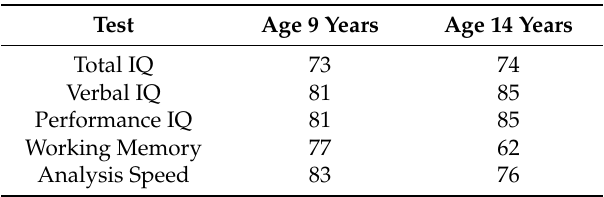
Table 2. Cognitive testing results show decreases in working memory and analysis speed from age 9 years to age 14 years. (Average IQ is 100; standard deviation is ± 15